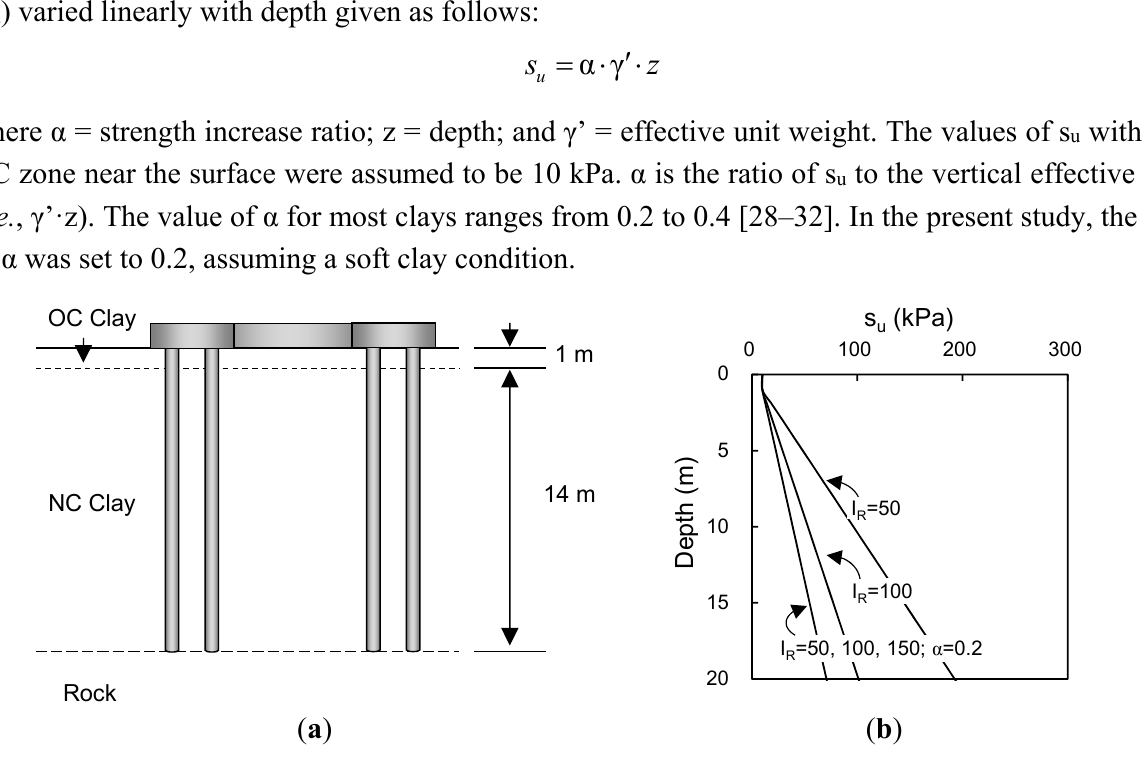
Figure 5. Soil conditions for finite element analysis: ( a ) soil layer condition and ( b ) depth profile of considered soil